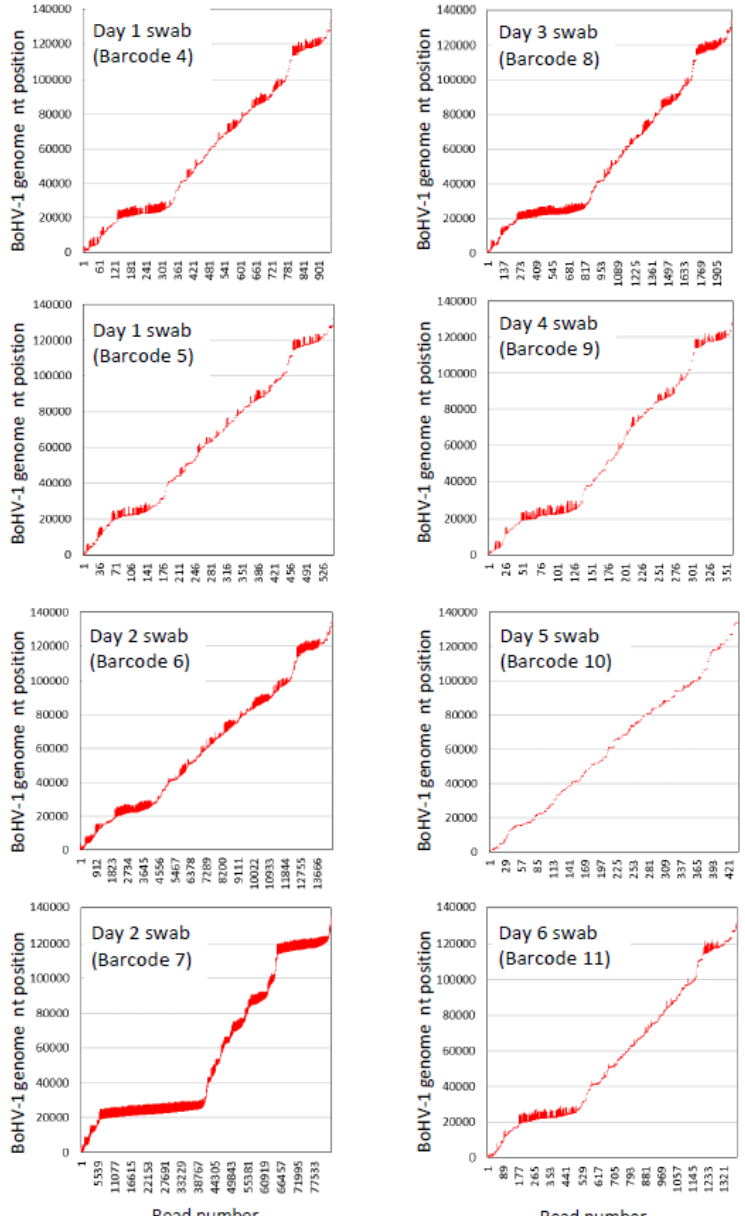
Figure 4. Epi2ME custom Fastq (Minimap 2) alignments of nanopore reads (represented by vertical red lines) from nasal swabs (one nucleic acid extraction per swab) from calf BoHV1_1 with the bovine herpesvirus type 1.1 complete genome sequence (GenBank accession number AJ004801.1).